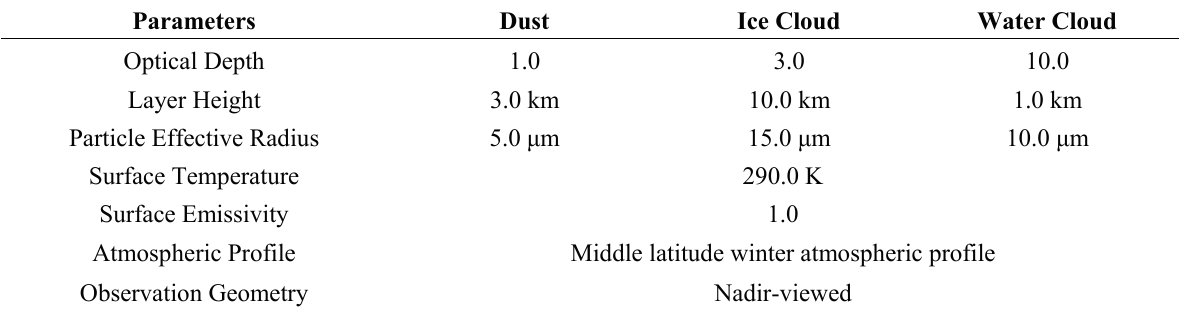
Table 1. The default input parameters for the forward